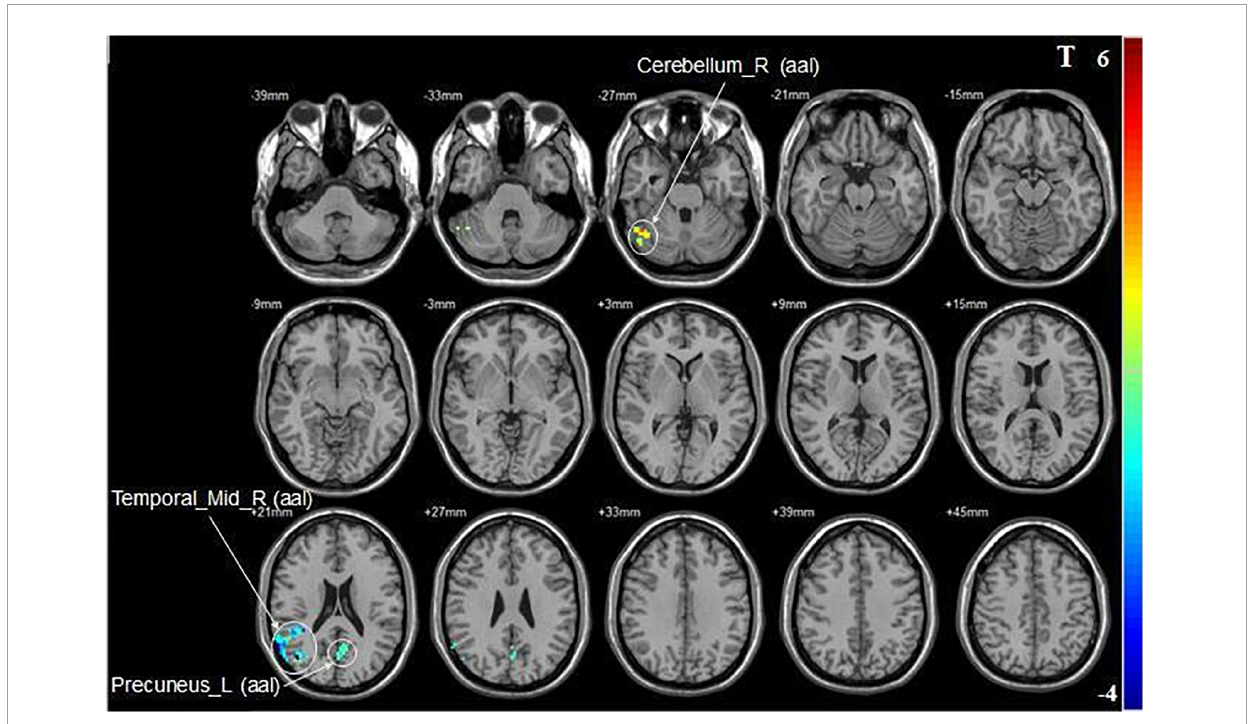
FIGURE2 Statistical maps showing fALFF change pre- and post-iTBS in the dominant cerebellum group. Warm colors showing fALFF increased and cool colors showing fALFF decreased after iTBS.